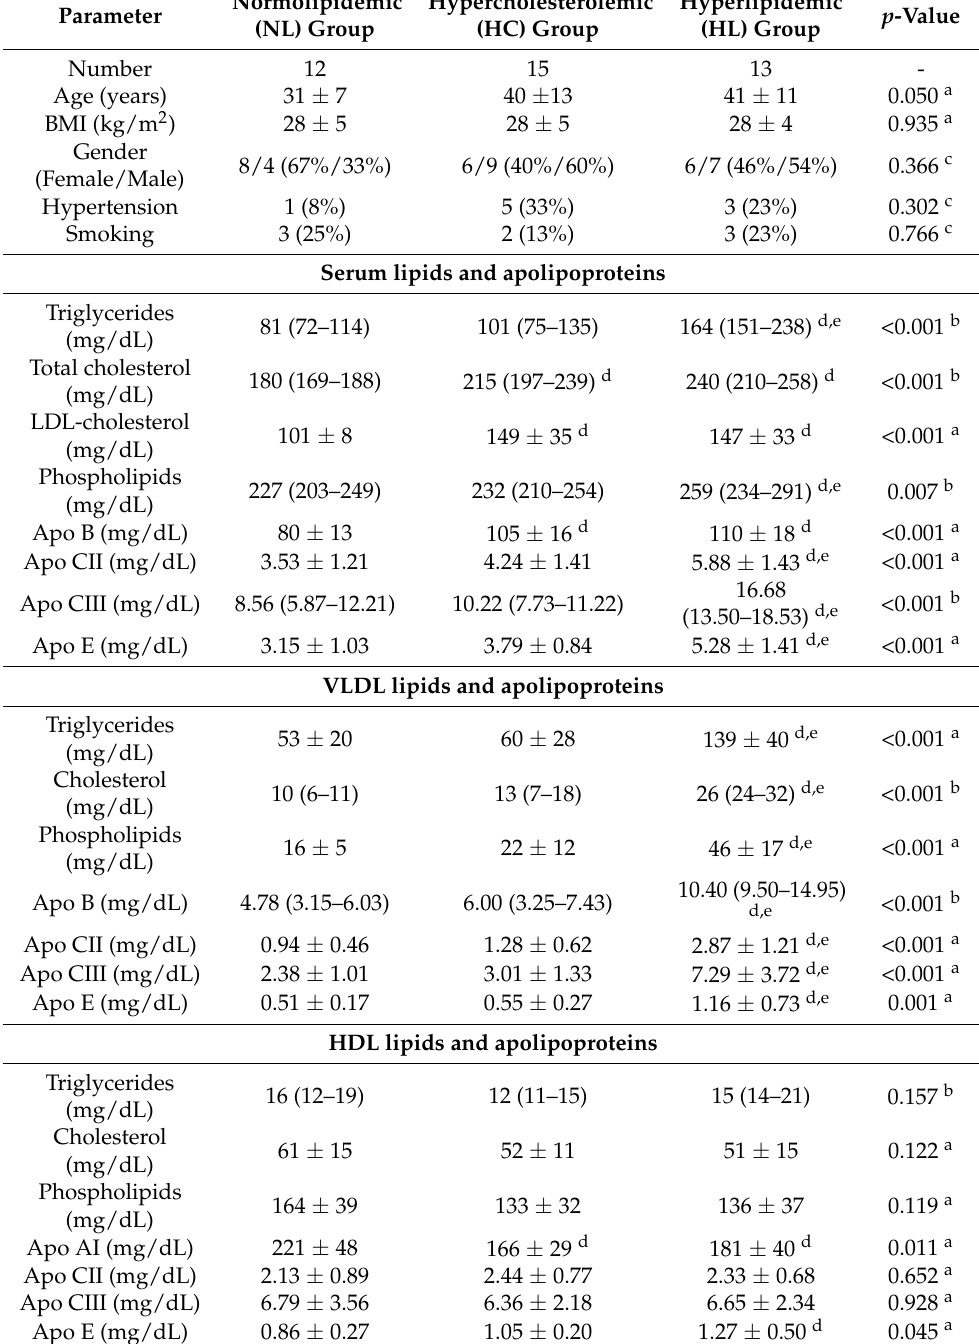
Table 1. Characteristics of study groups and lipid and apolipoprotein